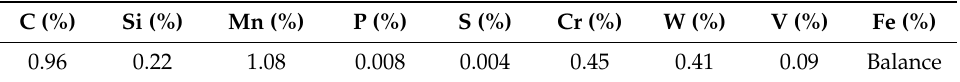
Table 1. Chemical composition of the workpiece